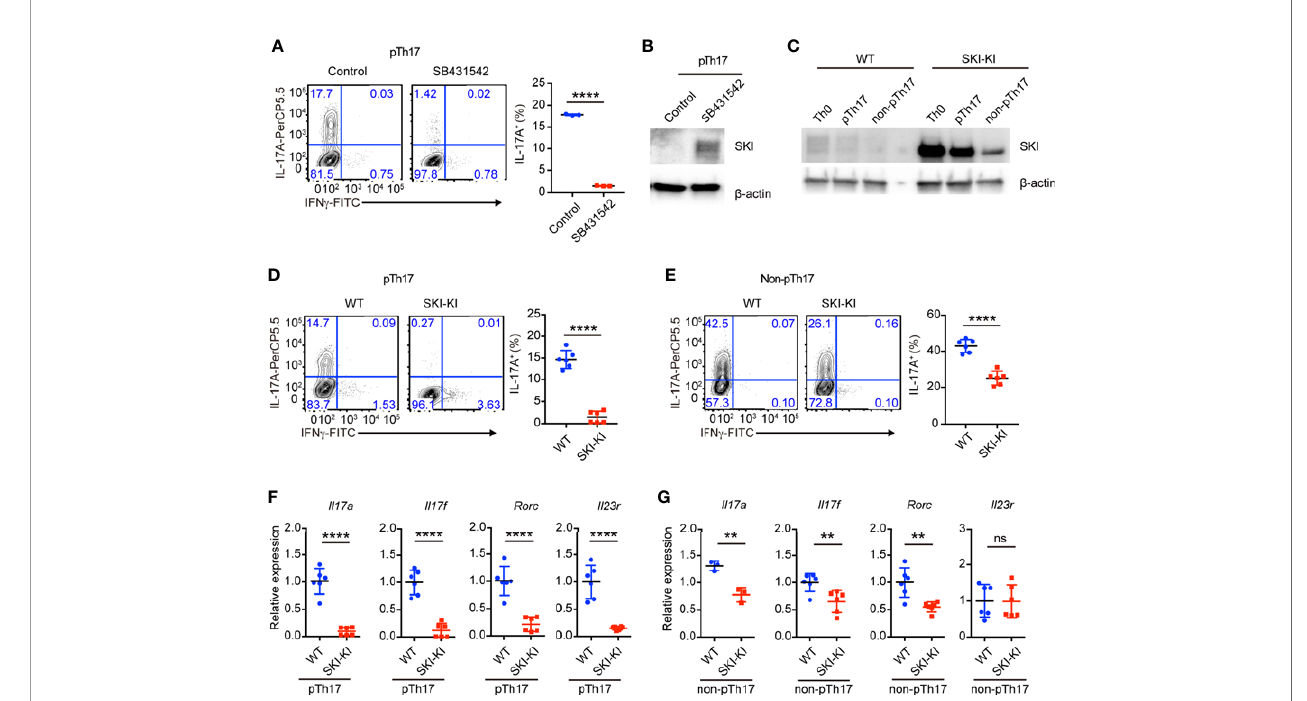
FIGURE 1 | TGF b signaling was required for pathogenic Th17 differentiation. (A) Flow-cytometry of IFN g - or IL-17A-producing CD4 + cells from WT mice cultured under pathogenic Th17 (pTh17, anti-CD3/CD28 plus IL-1 b , IL-6 and IL-23) polarizing conditions for four days in the presence or absence of TGF b receptor inhibitor SB341542. Left, representative plot; right, composite data, n = 3 mice of three experiments; bars indicate the mean values, means ± s.d., **** p < 0.0001, by two- sided Student ’ s t -test. (B) Immunoblot analysis of SKI and b -actin in WT CD4 + T cells cultured under pathogenic Th17 (pTh17, anti-CD3/CD28 plus IL-1 b , IL-6 and IL-23) polarizing conditions for 24 h in the presence or absence of TGF b receptor inhibitor SB341542. Data were representative of three independent experiments. (C) Immunoblot analysis of SKI and b -actin in WT and SKI-KI CD4 + T cells cultured under Th0 (anti-CD3/CD28 plus IL-2), pathogenic Th17 (pTh17, anti-CD3/CD28 plus IL-1 b , IL-6 and IL-23) and non-pathogenic Th17 (non-pTh17, anti-CD3/CD28 plus TGF b and IL-6) polarizing conditions for 24 h. Data were representative of three independent experiments. (D) Flow-cytometry of IFN g - or IL-17A-producing CD4 + cells from WT and SKI-KI mice cells cultured under pathogenic Th17 (pTh17, anti-CD3/CD28 plus IL-1 b , IL-6 and IL-23) polarizing conditions for four days. Left, representative plot; right, composite data, n = 6 mice of three experiments; means ± s.d., **** p < 0.0001, by two-sided Student ’ s t -test. (E) Flow-cytometry of IFN g - or IL-17A-producing CD4 + cells from WT and SKI-KI mice cells cultured under non-pTh17 (anti-CD3/CD28 plus TGF b and IL-6) polarizing conditions for four days. Left, representative plot; right, composite data, n = 6 mice of three experiments; means ± s.d., **** p < 0.0001, by two-sided Student ’ s t -test. (F, G) The mRNA expression of Il17a , Il17f , Rorc and Il23r in pTh17 (F) and non-pTh17 (G) cells as in (D) and (E) respectively. Relative expression levels were measured by quantitative real-time RT-PCR and were normalized to actin expression level using the standard curve method. The results were from three independent experiments; n = 3 – 6 mice of three independent experiments; means ± s.d., ns, not signi fi cant, ** p < 0.01, **** p < 0.0001, by two-sided Student ’ s t